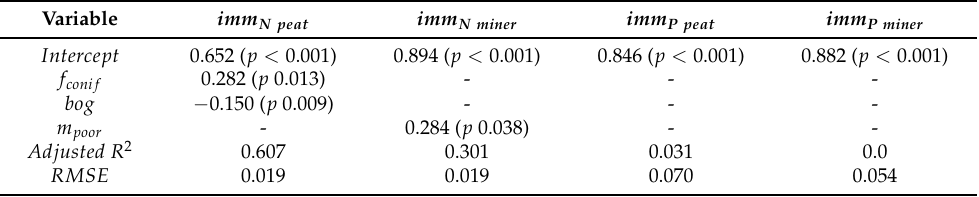
Table 3. Nitrogen and phosphorus immobilization parameters as a function of catchment char- acteristics calculated using stepwise regression analysis. Catchment characteristics are shown in Tables 1 and